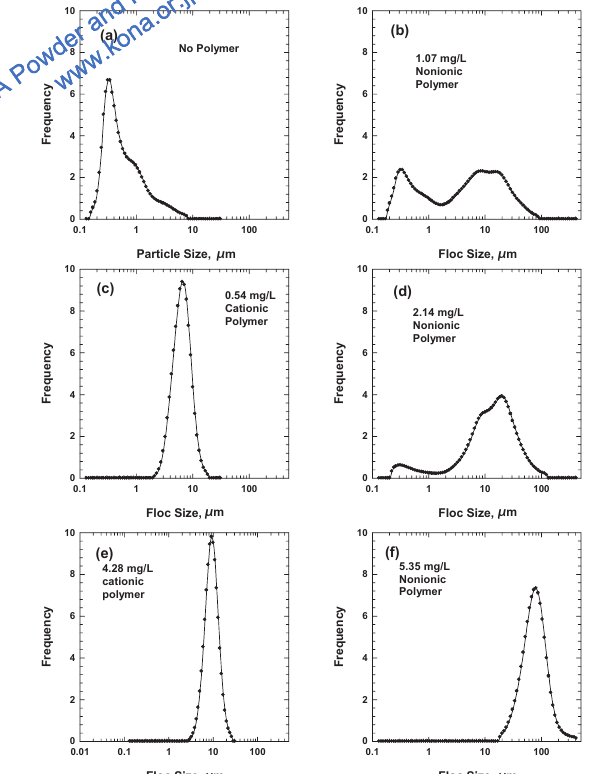
Fig. 3 Floc size distributions resulting from the appli- cation to an initially stable alumina suspension (plot a) of a 0.5 million molecular weight cat- ionic polymer (plots c and e) and a 15 million molecular weight nonionic polymer (plots b, d and f). Data of Rattanakawin 10) .